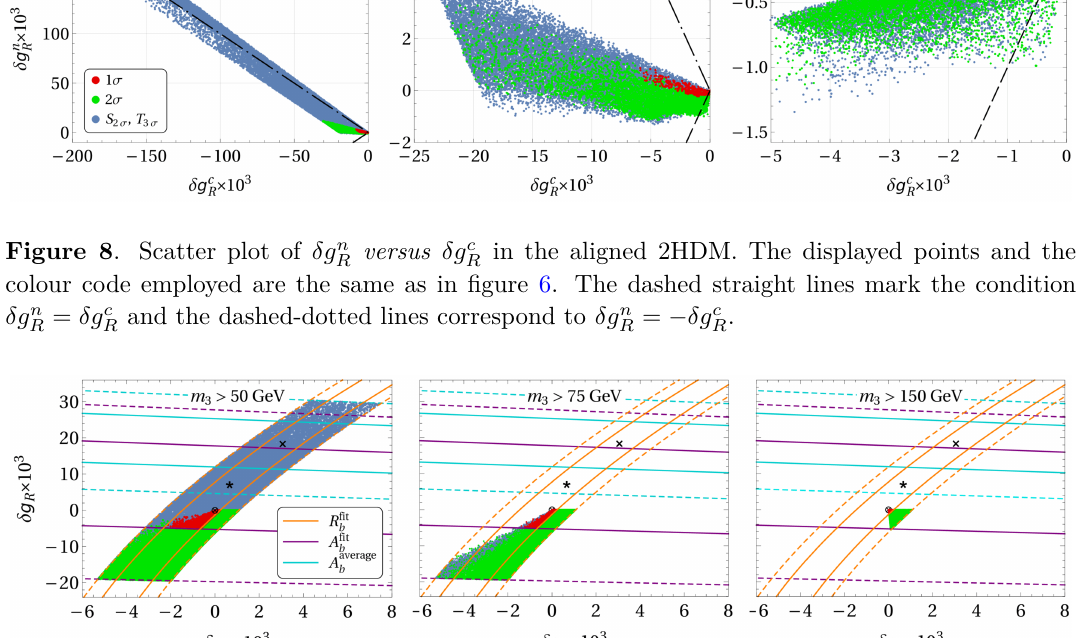
Figure 9 . Scatter plot of values of δg L and δg R in the aligned 3HDM. All the conventions are the same as in figure